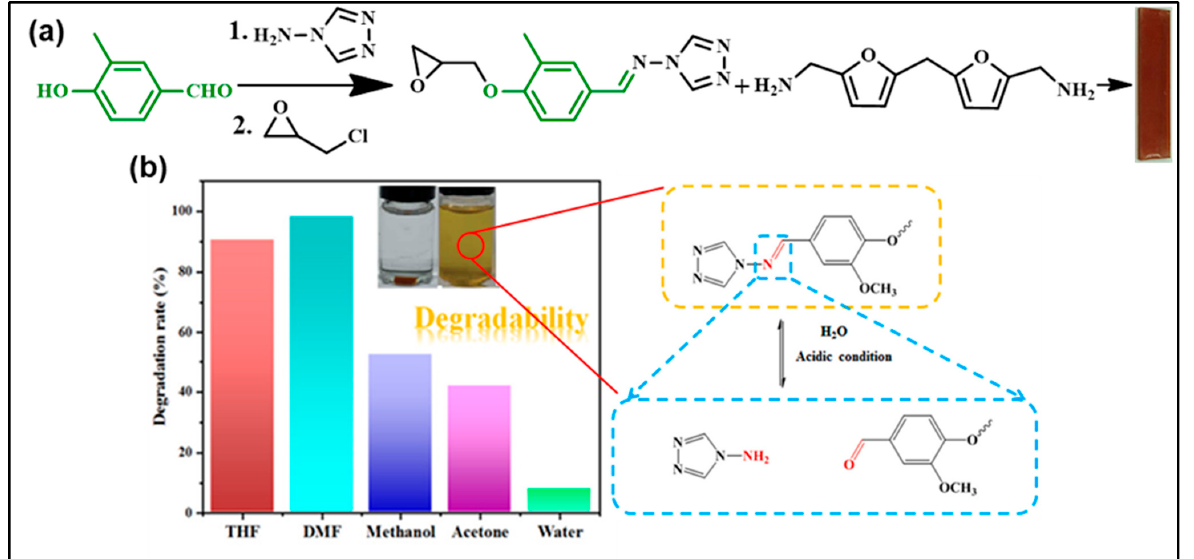
Figure 19. ( a ) Vanillin-modified epoxy monomer (VTA-EP) and its thermoset synthesis pathway, ( b ) degradability of fully green vitrimer (VTA-EP/DFA) at different solvents and its degradation mechanism [reproduced with permission from Nabipour et al.; published by Elsevier, 2021] [82].